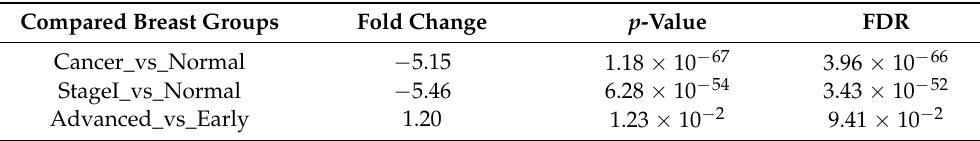
Table 2. ENPP2 differential expression analysis results based on TCGA data. |FC| > = 1.2 and FDR < 0.05 are considered as thresholds of significant